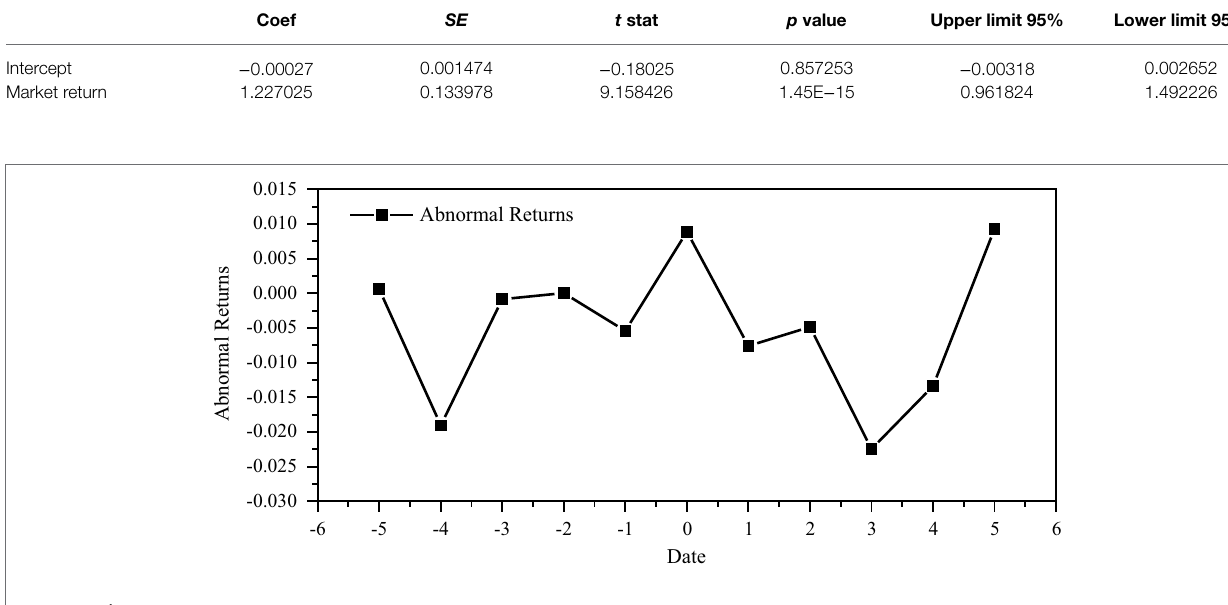
TABLE 15 | Changes in abnormal returns.